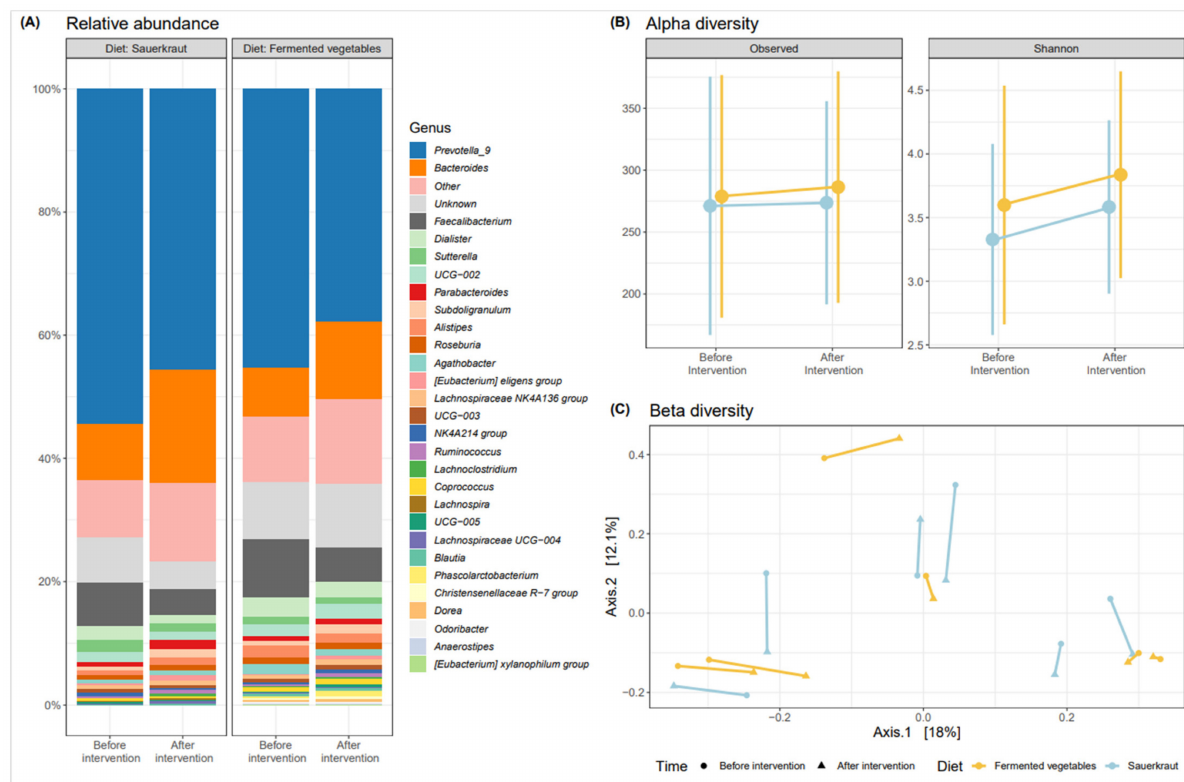
Figure 3. Human gut microbiome changes after consumption of fermented vegetables. ( A ) Grouped relative abundance of the main phyla found in the stool samples—the most abundant genera are displayed in the chart, genera that had a relative abundance of more than 0.1% in half of the samples were aggregated into one category (“Other”), and genera with no taxonomic annotation are categorized as “unknown”; ( B ) alpha diversity measures representing the diversity of bacterial taxa before and after intervention; ( C ) beta diversity of bacterial taxa found in the stool samples displaying each